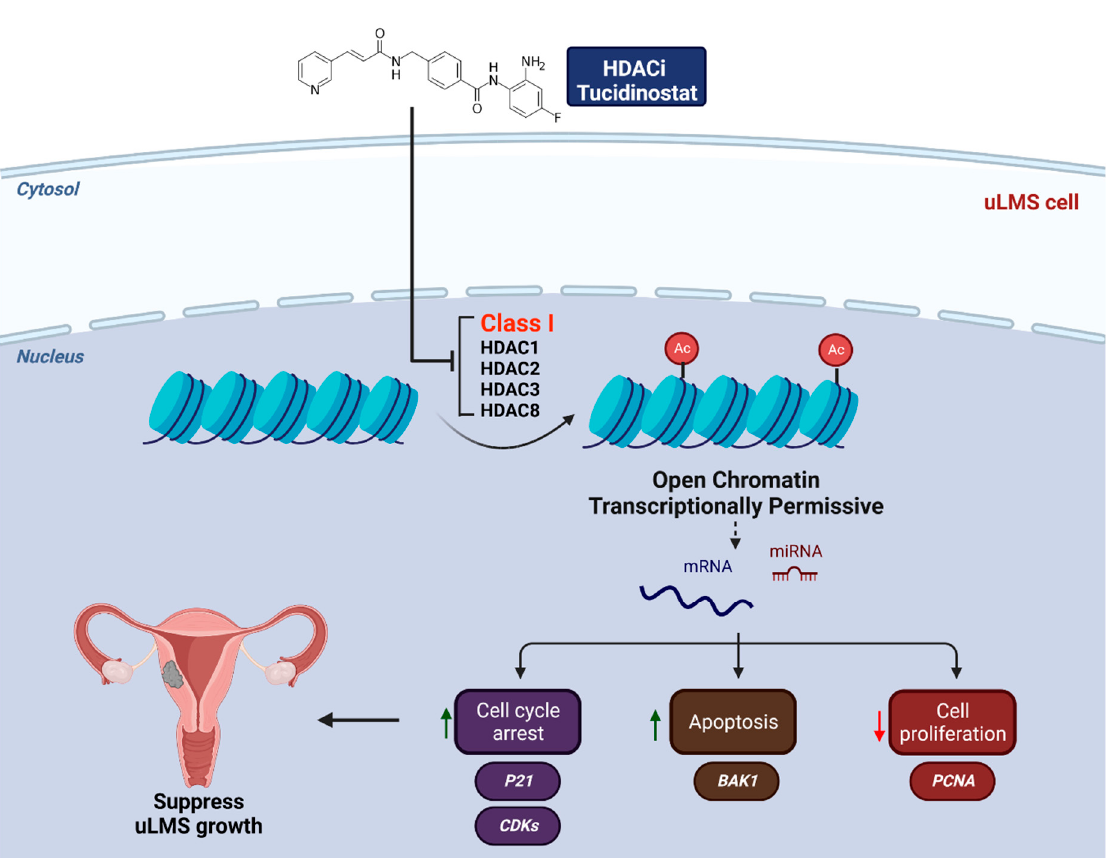
Figure 17. Experimental model. The model shows that Tucidinostat and DL-sulforaphane activate apoptosis, induce cell cycle arrest, induce miRNA-mediated gene regulation, and reprogram pro- oncogenic epigenome in uLMS cells. Note: Arabic numerals are the index for histone modifications.